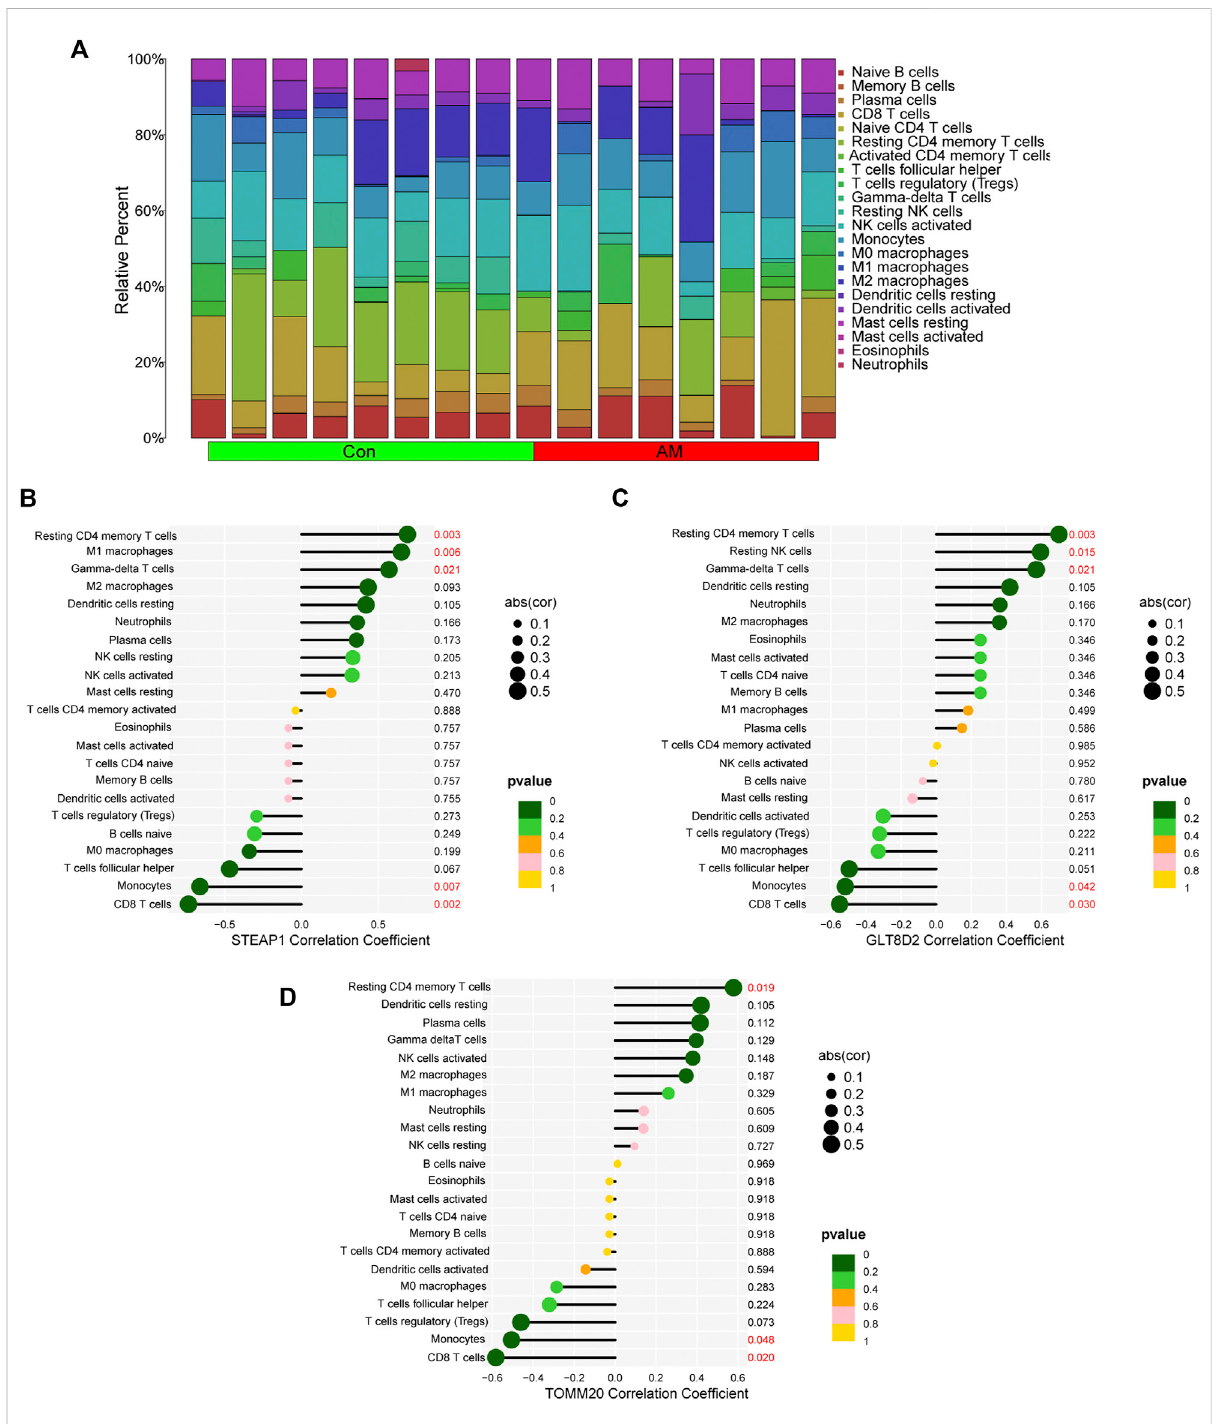
FIGURE 7 Correlationbetweendiagnosticbiomarkersandin fi ltratingimmunecellsusingCIBERSORT. (A) Thebarplotofproportionof22immunecellsin the endometrium of women with adenomyosis and control group analyzed using CIBERSORT. (B – D) The correlation between STEAP1, GLT8D2, TOMM20 and in fi ltrating immune cells. GLT8D2: glycosyltransferase eight domain-containing 2, STEAP1: six-transmembrane epithelial antigen of the prostate-1, TOMM20: translocase of outer mitochondrial membrane